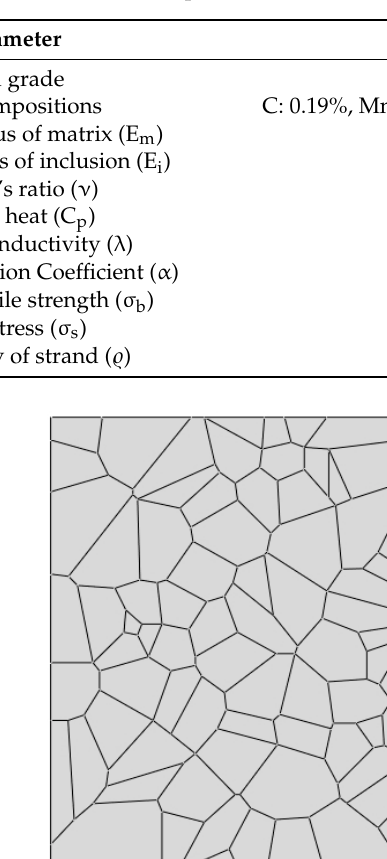
Table 1. Main parameters used in the simulation.